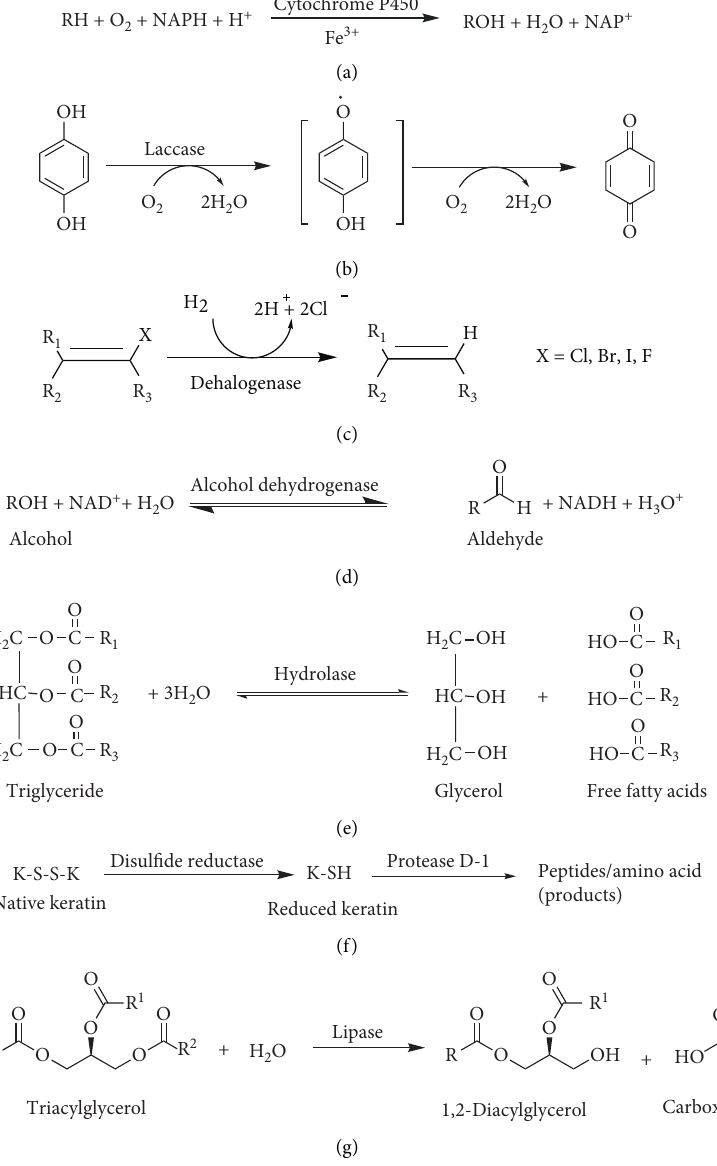
Figure 1: Some microbial enzymes used in bioremediation; general enzymatic reactions catalyzed by (a) cytochrome P450, (b) laccase, (c) dehalogenase, (d) dehydrogenase, (e) hydrolase, (f) protease, and (g)